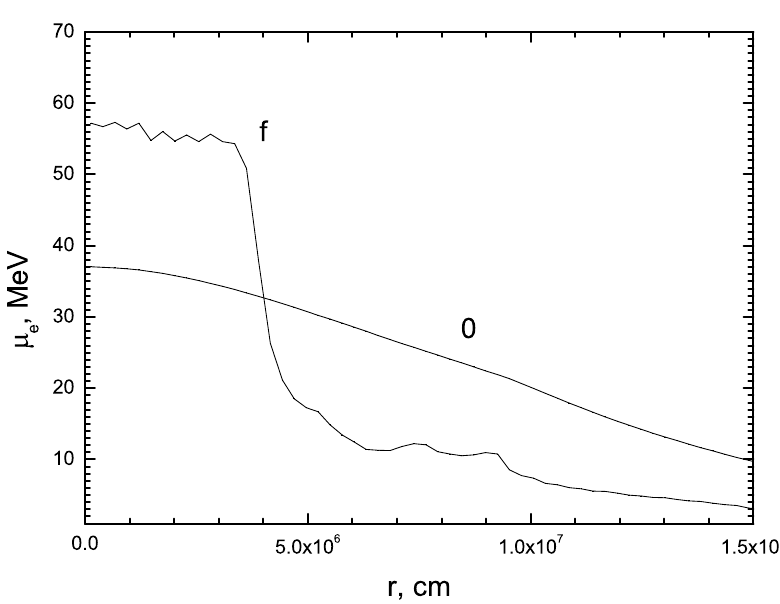
Figure 1. Profile of chemical potential of electrons at the beginning of calculations ( t ≈ 0) and in the end of 2D calculations ( t f = 12 ms) as a function of cylindrical radius in the equatorial